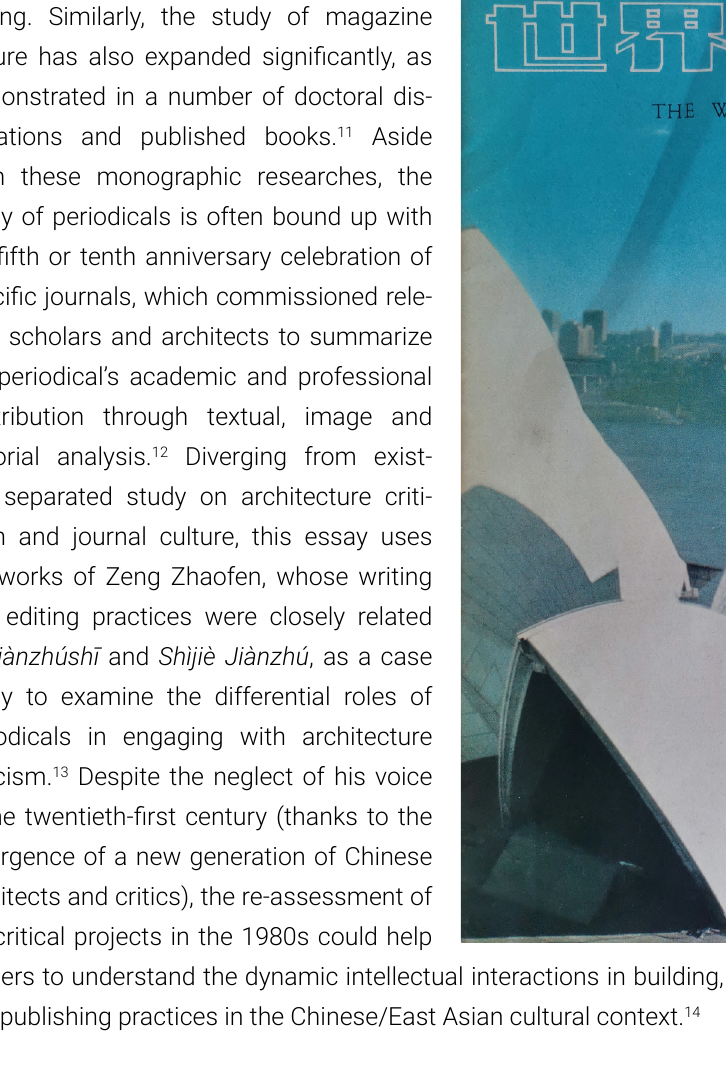
The cover of Shìjiè Jiànzhú , 1980, no.